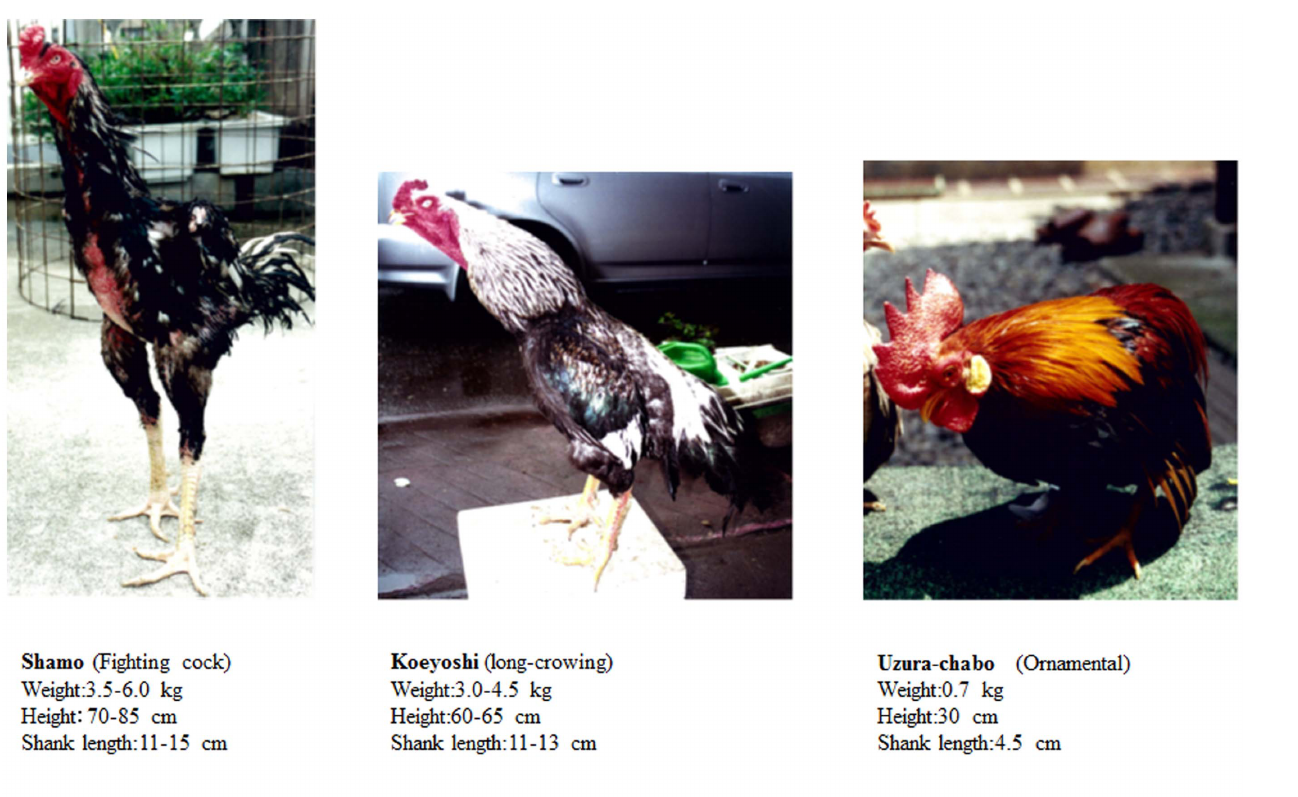
Figure 2. The three domesticated varieties examined in this study. In Japan, there are 17 distinct varieties of ornamental domesticated chickens, which are famous for their characteristic varied body color and forms. These chickens continue to be bred for these different characteristics by breeders.